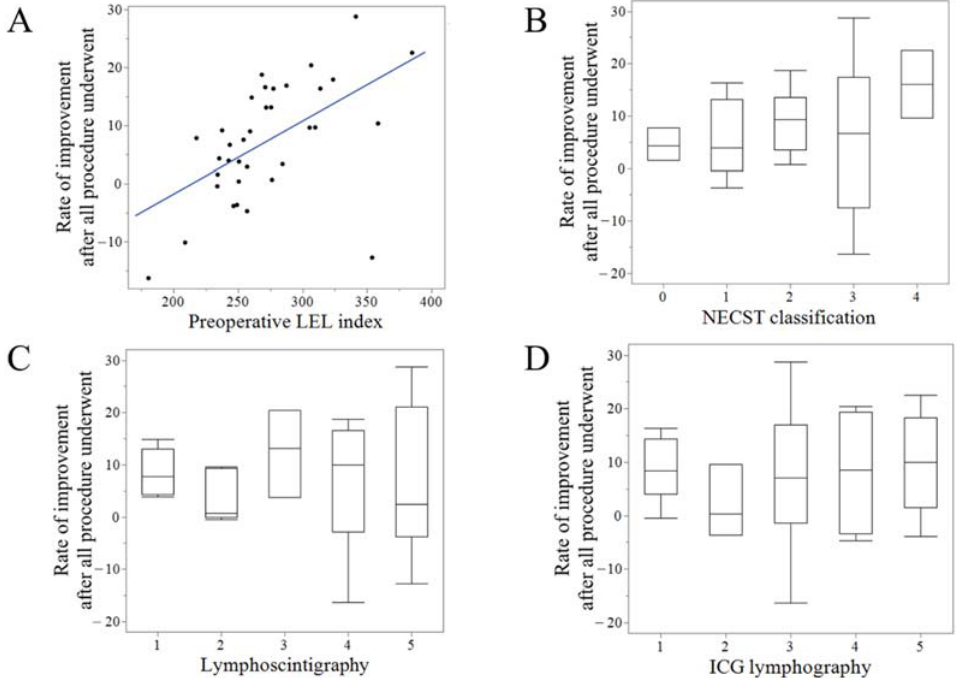
Figure 9. Correlation between the final results of lymphatic surgery and clinical parameters. The rate of improvement (RI) after all the procedures were performed exhibited strong positive correlations with the preoperative LEL index (r = 0.62, p < 0.001) ( A ) However, the final RI did not correlate with any staging of the normal, ectasis, contraction, and sclerosis type classification (NECST) ( B ), lymphoscintigraphy ( C ), or ICG lymphography ( D ). Table 3. The multiple regression analysis of the factors related to lymphedema improvement after all surgical interventions.